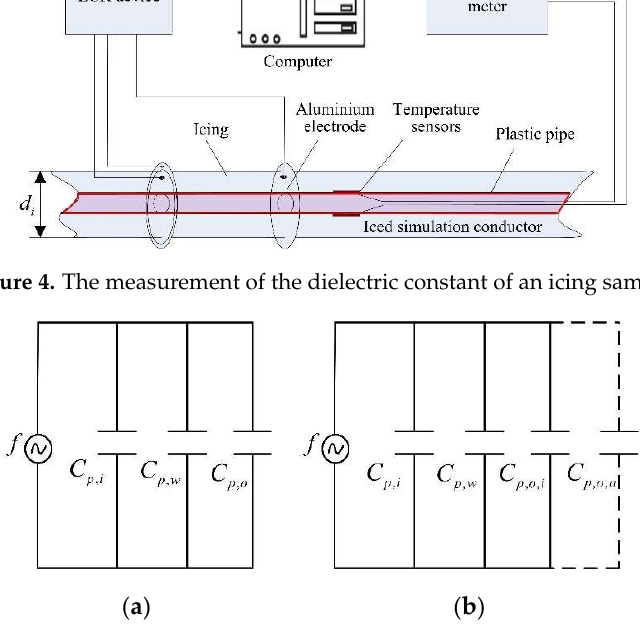
Figure 5. The equivalent circuit of the capacitive sensor, before and after icing accumulation: ( a ) The equivalent circuit before icing accumulation; ( b ) the equivalent circuit after icing accumulation.